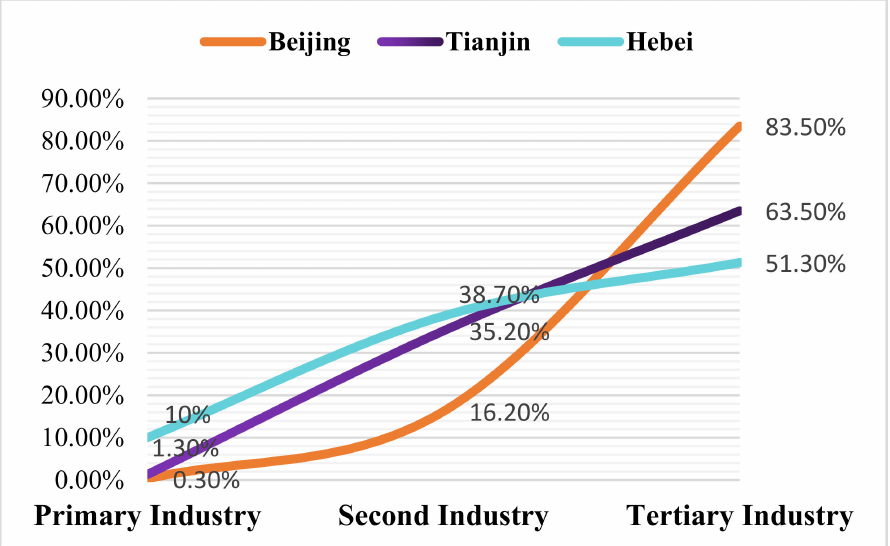
Figure 5. Proportion of industries in Beijing, Tianjin and Hebei